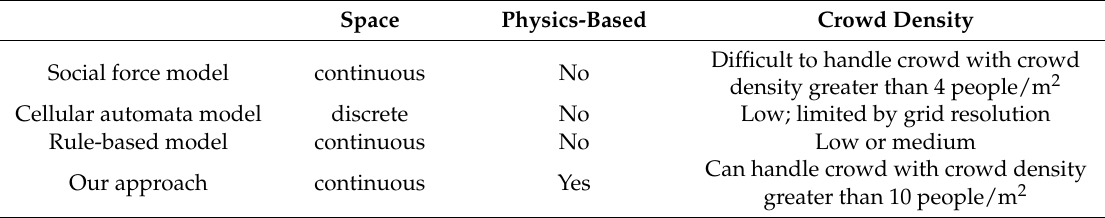
Table 4. Comparisons with classical crowd simulation